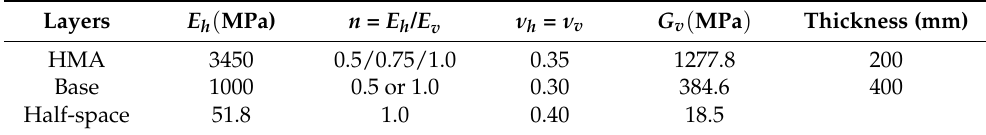
Table 4. Cases used for the analysis of the influence of the vertical Young’s modulus of trans- verse isotropy.